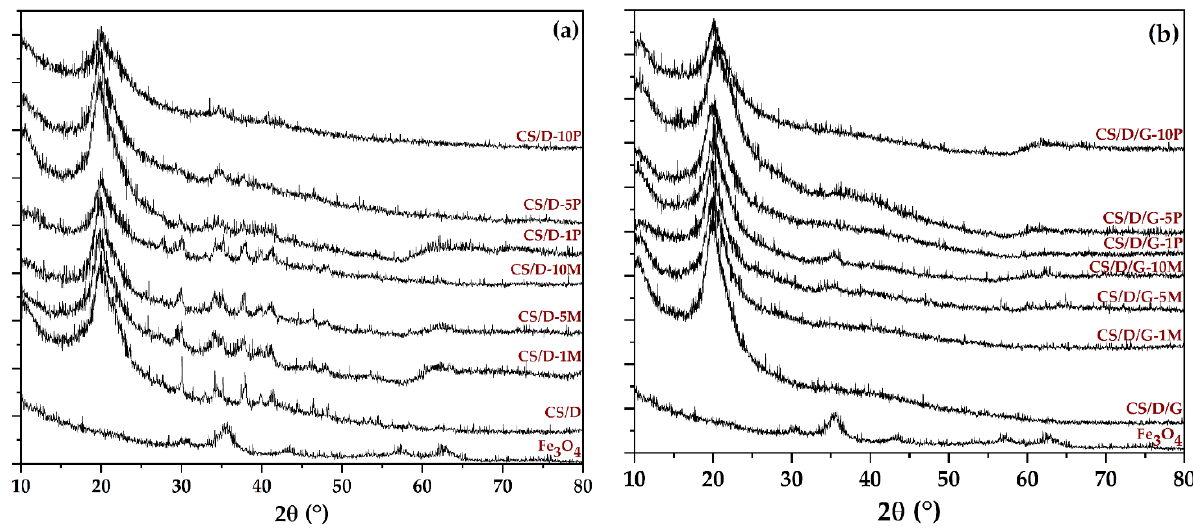
Figure 1. Diffractograms acquired for the CS/D ( a ) and CS/D/G ( b )